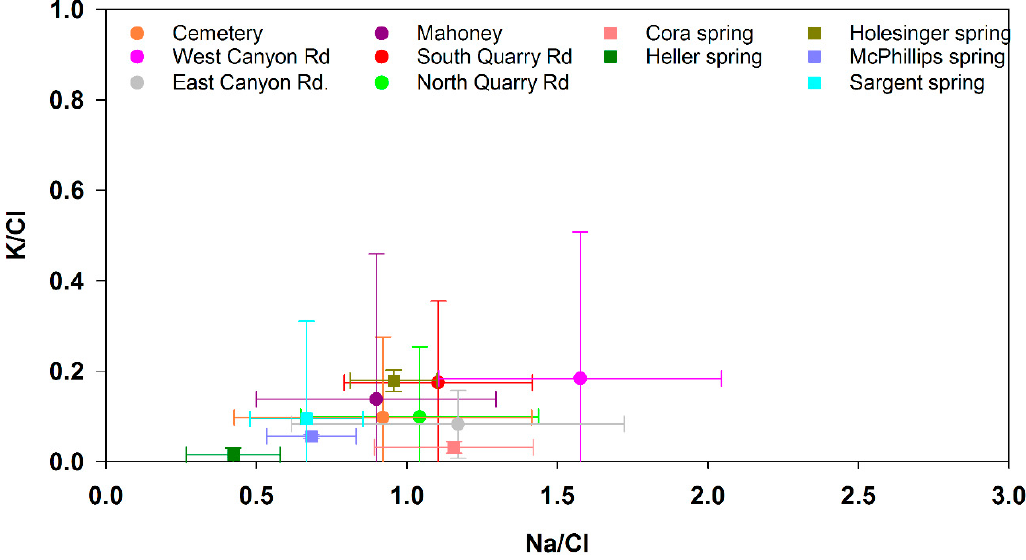
Figure 6. Molar Na/Cl ratios versus molar K/Cl ratios for the stream (circle) and spring (square) waters. Molar Na/Cl ratios close to 1.0 suggest halite influence while molar K/Cl ratios close to 1 support fertilizer, potash (KCl), influence. Points represent the mean value and the error bars indicate a standard deviation for the given location.